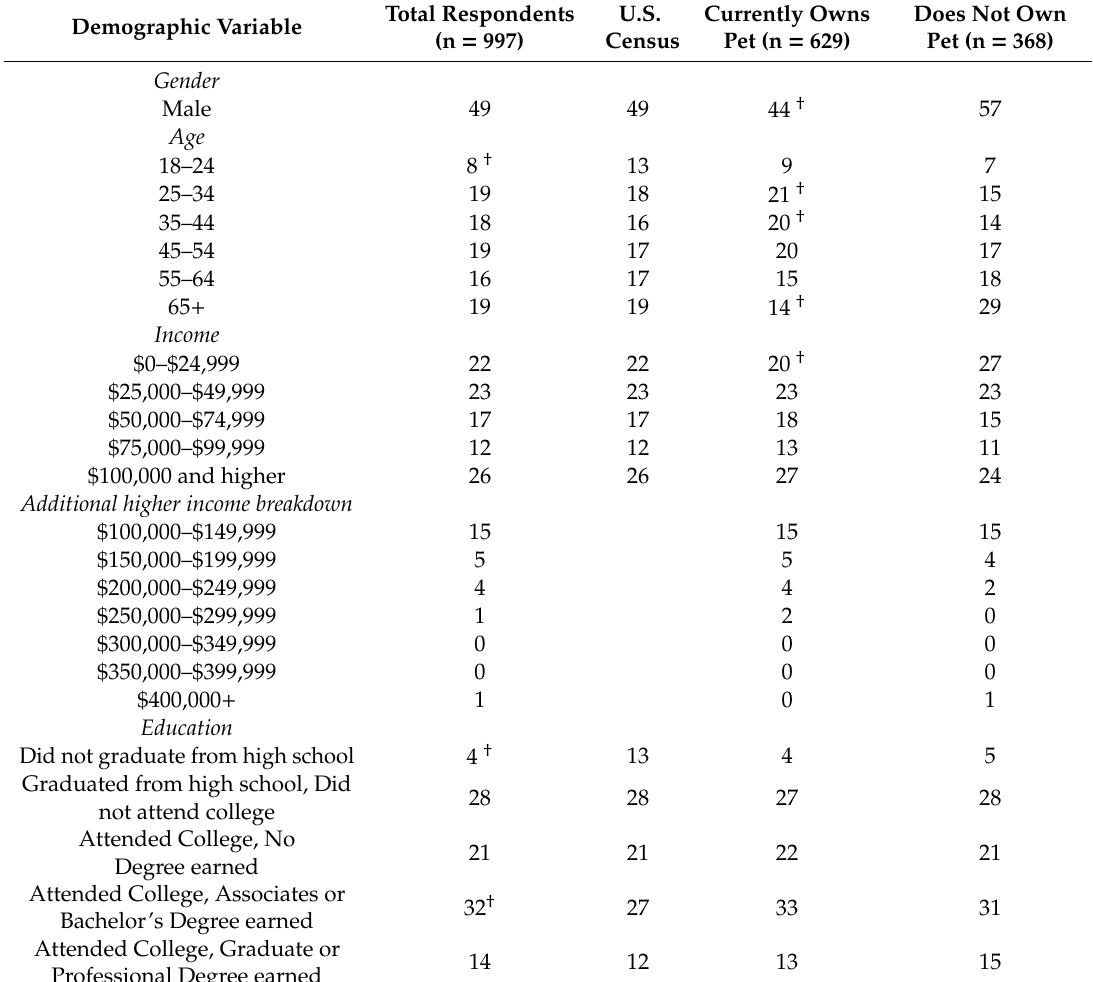
Table 1. Survey demographics and demographics of pet owners and comparison between samples, percentage of